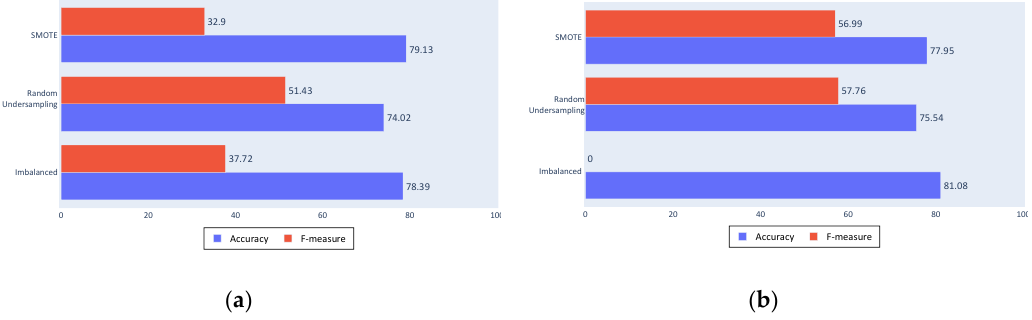
Figure 10. ( a ) Complete process decision tree results; ( b ) Complete process Support Vector Machine (SVM) results.